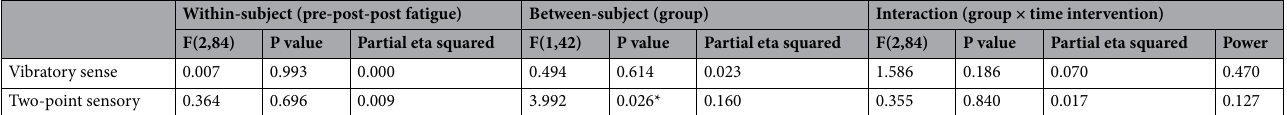
Table 6. Statistical results of superficial sensory test among the three groups of placebo taping, inhibition taping, and facilitation taping. * p < 0.05.